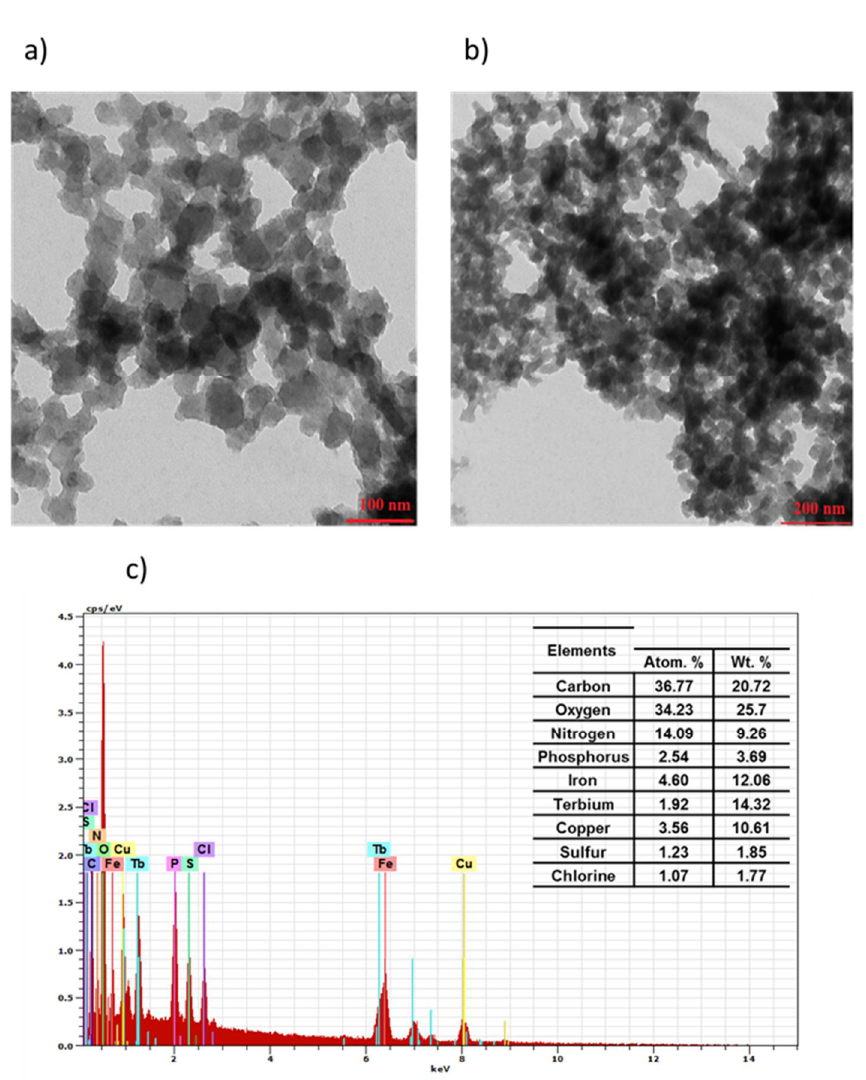
Figure 2. TEM images ( a , b ) and EDS spectrum ( c ) of IONPs@CA_GMP_Tb 3+ (scale bar = 100 nm and 200 nm).